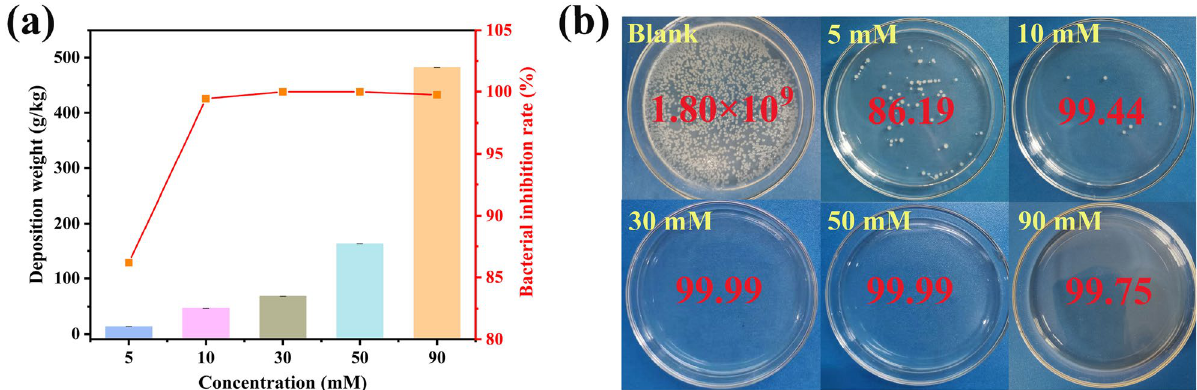
Figure 3. ( a ) Relationship among antibacterial rate and amount of Ag deposition layer as well as concentration of silver ammonia; ( b ) Digital camera pictures of bacterial culture plates showing antibacterial activity of blank sample and Ag/PVA/PP fabrics obtained with 5 mM, 10 mM, 30 mM, 50 mM, and 90 mM of silver ammonia against E. coli.